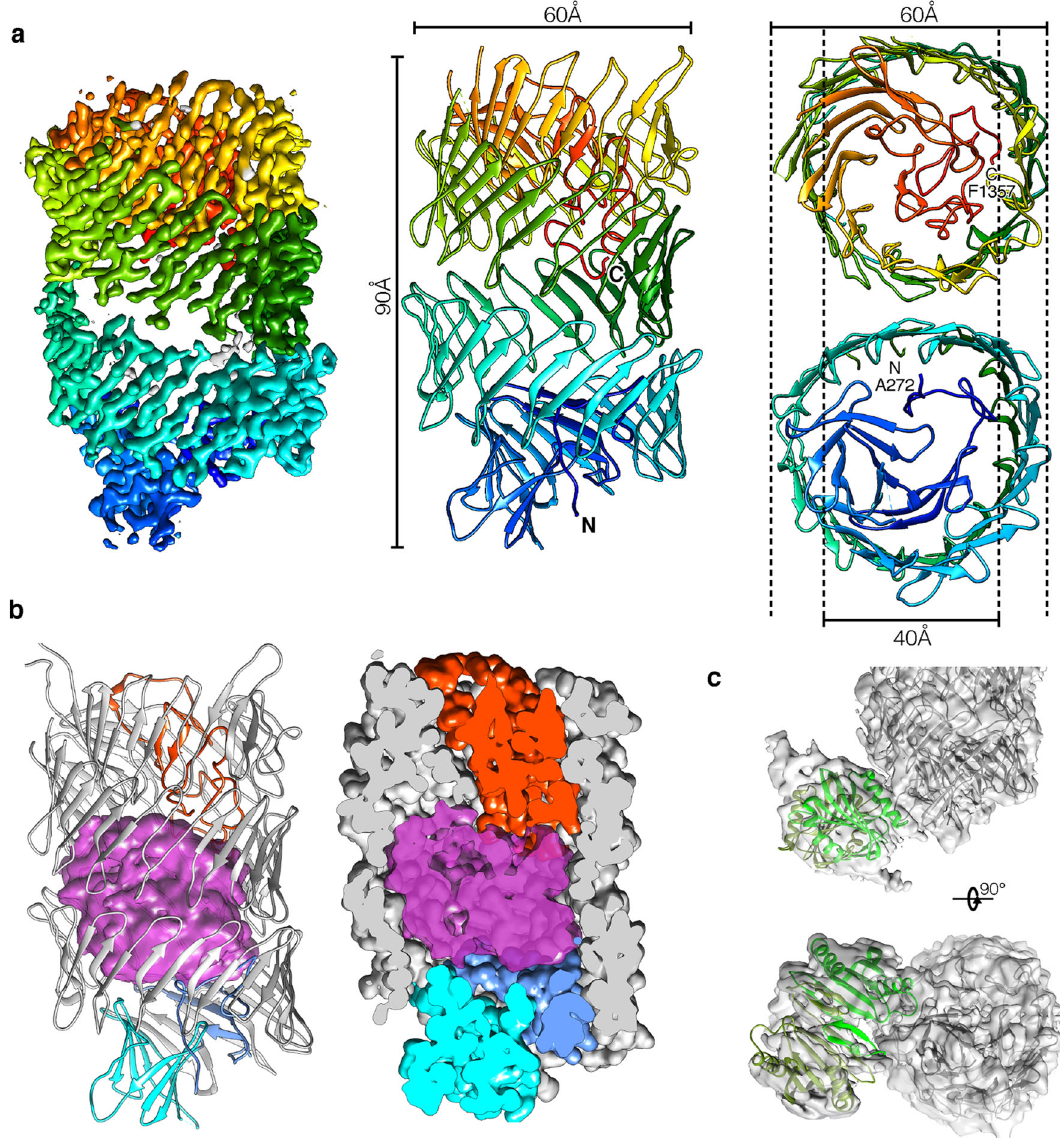
Fig. 3 Cryo-electron microscopy structure of the Rhs1-EagR complex. a P. laumondii Rhs1 cryo-EM density map and model. Unsharpened masked cryo-EM map (left panel – 0.015 contour level) of the Rhs1 β -barrel colored accordingly to the fi tted side view of the molecular model (central panel), on a blue (N- terminal) to red (C-terminal) gradient. Slices of the N-terminal (right panel-top) and C-terminal (right panel-bottom) regions are shown in a perpendicular orientation in order to highlight the plugs on each side of the β -barrel, with dotted lines depicting their inner and outer diameters and labels marking the N- and C-terminal sites with respective residue numbers. b Structural evidence for toxin localization inside the Rhs1 β -barrel. Amorphous low-resolution density shown in the center of the β -barrel (left), generated by subtracting all the unsharpened masked map (0.003 contour level) within 2 Å radius of the molecular model, indicated the presence of a highly fl exible or unfolded sequence in the central space. By generating a 2 Å molecular density around the model (right panel), the interaction with the N- and C-terminal plugs is evidenced. The N-terminal seal and Ig-like plug domains are shown in blue and cyan, respectively, the C-terminal plug is shown in red, and the C-terminal Rhs1 CT toxin is shown in magenta. c EagR-Rhs1 NT interaction. Density of the N-terminal region in the unmasked map (0.004 contour level) is shown in transparency, with fi tted Rhs1 (gray) and EagR dimer model (light and dark green). Only the EagR dimer model is fi tted into the Rhs1 NT -EagR